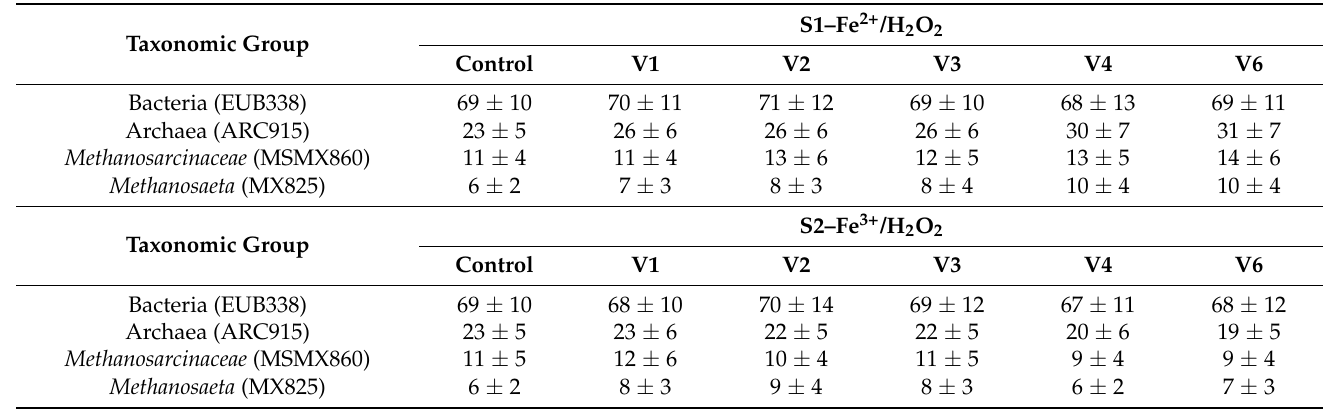
Table 5. Microbial populations in AS across experimental